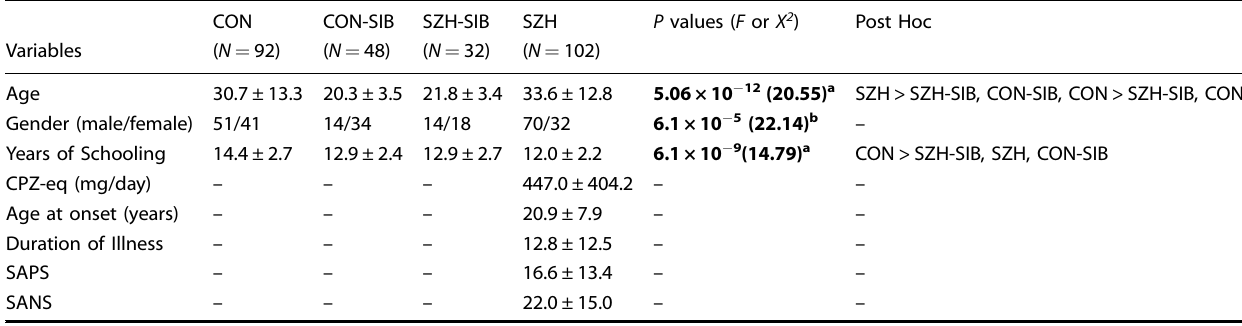
Table 3. Demographic characteristics of the sample by diagnostic